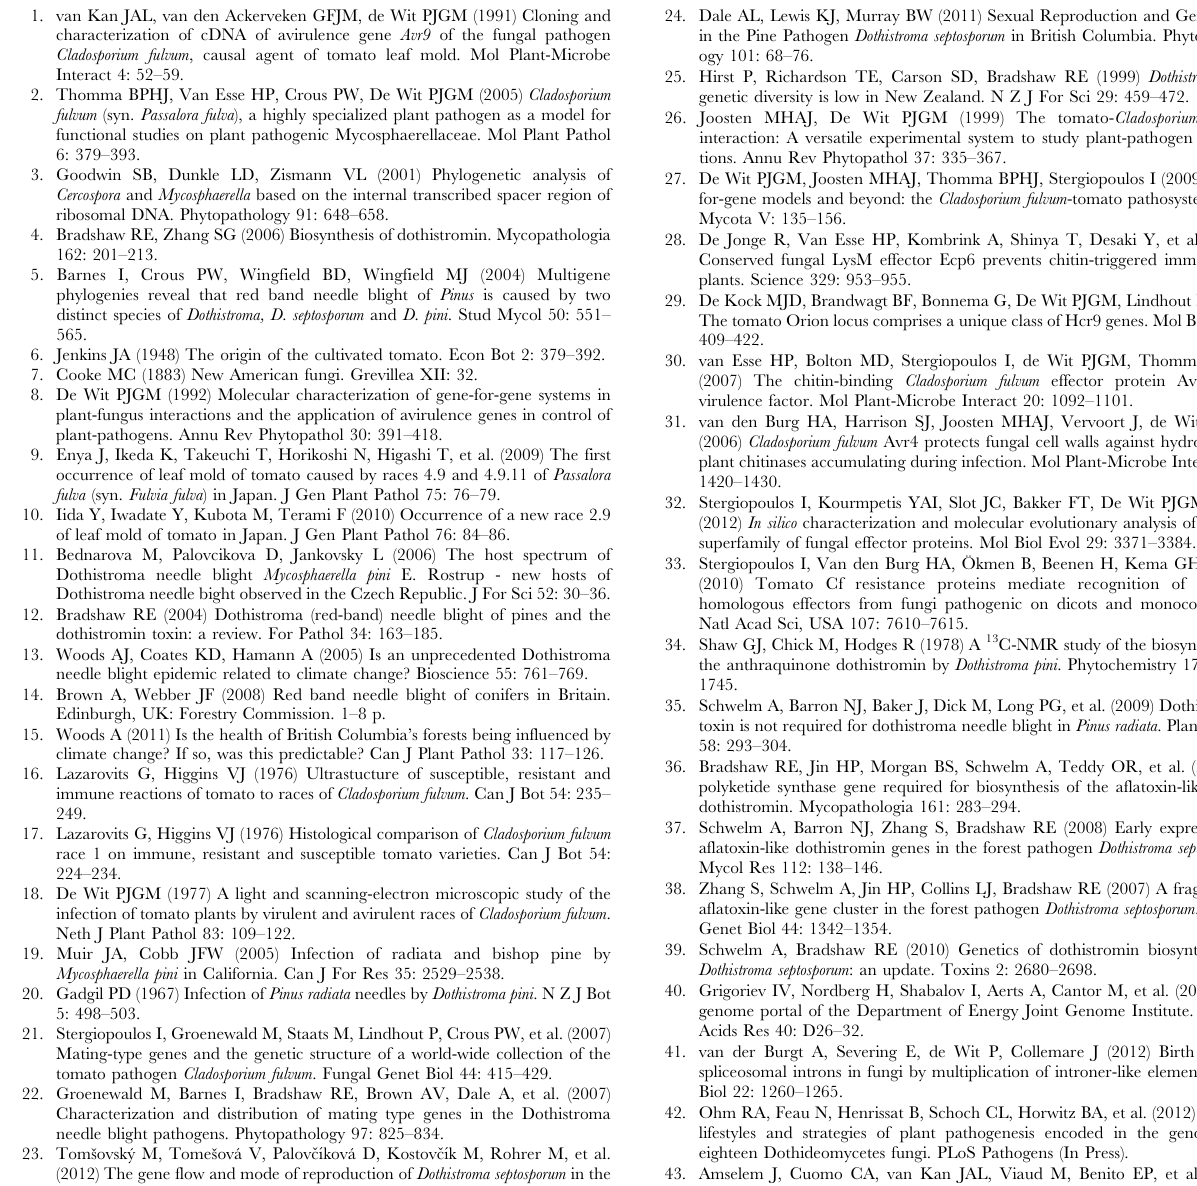
Table S13 Conditions for Dothistroma septosporum EST libraries. (DOC) Table S14 Primers used for reverse transcription quantitative